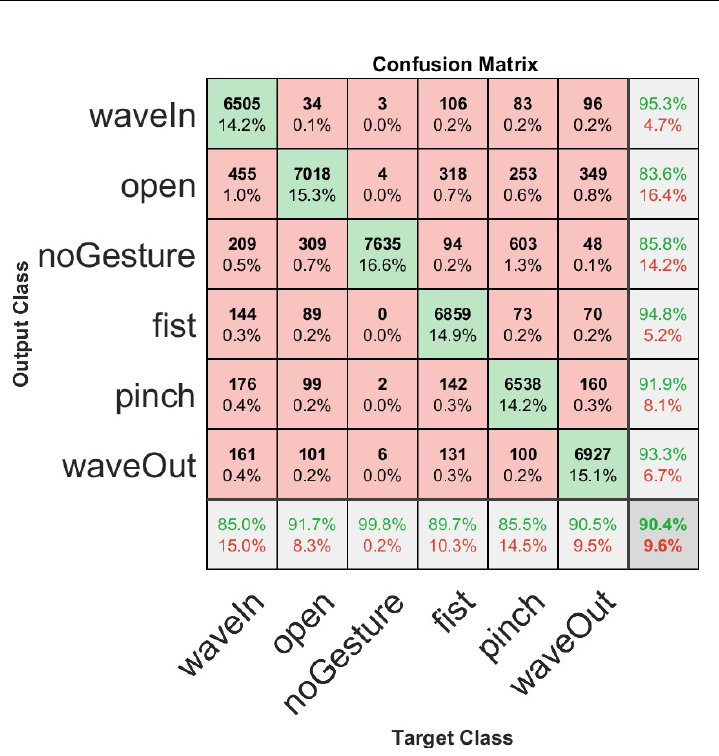
Figure 10. User-specific HGR model confusion matrix for 306 users of the test set with the best hyperparameter configuration. Each hand gesture class result can be observed in